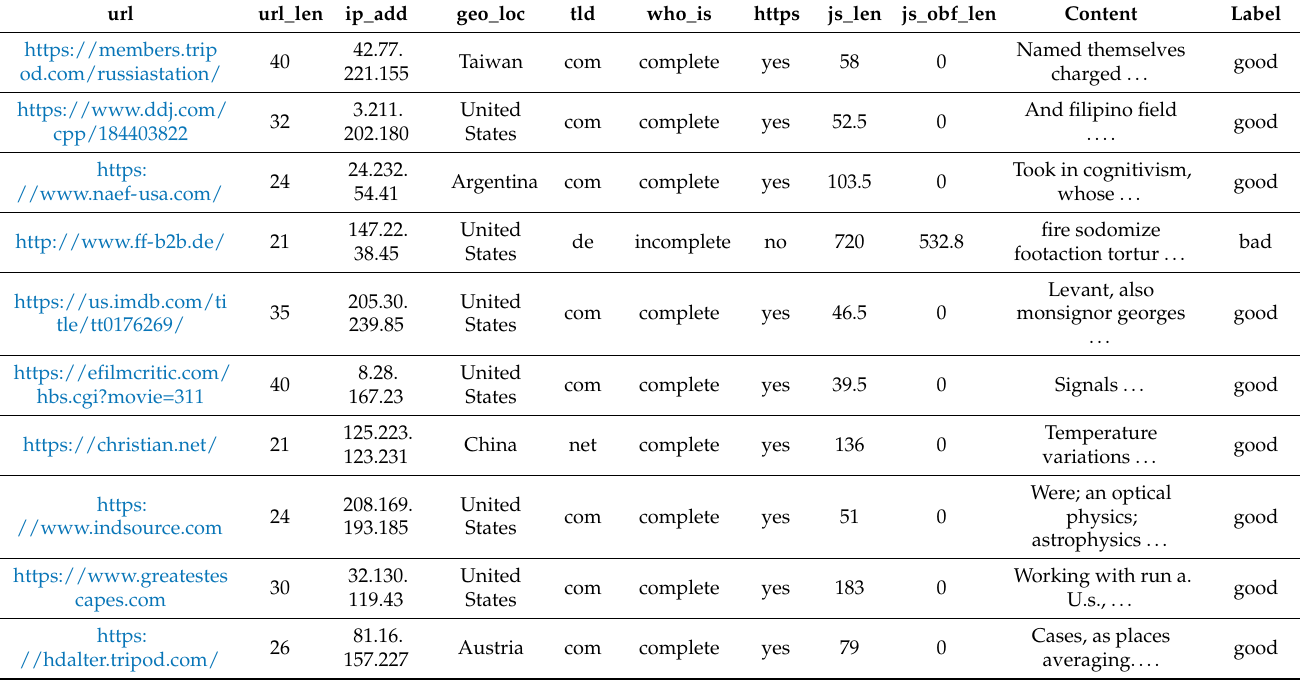
Figure 1. The schematic overview of research methodology. Table 2. The example of the dataset in initial form (accessed on 10 October